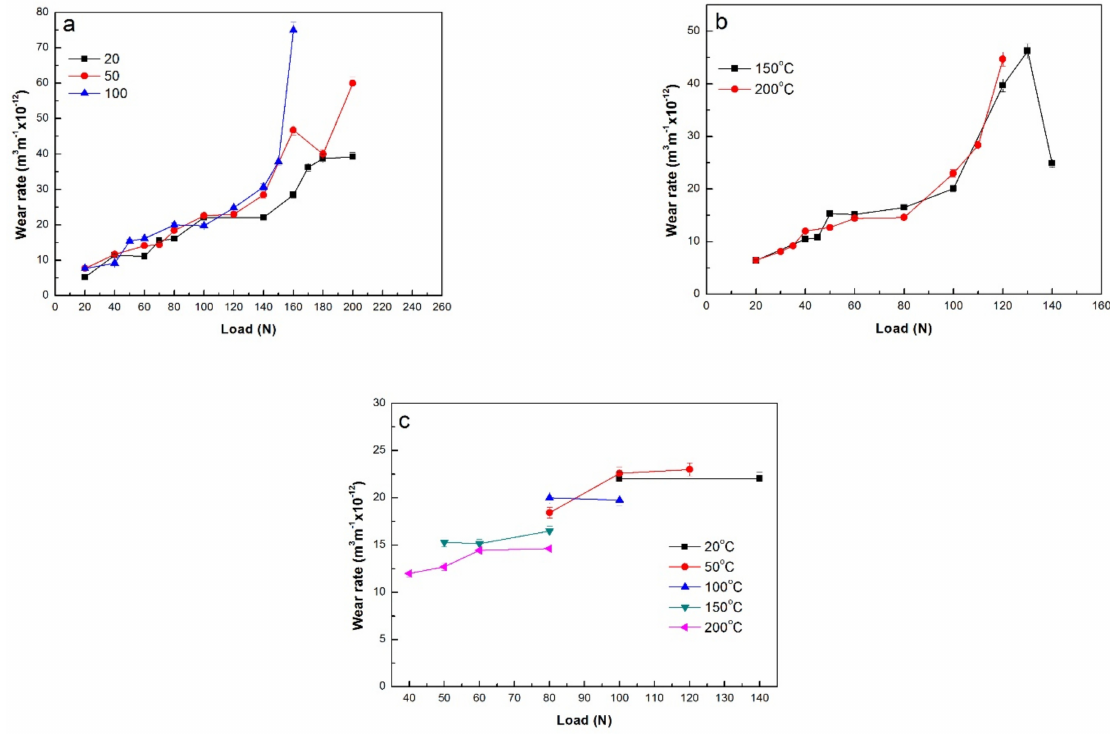
Figure 2. Wear rate versus applied load: ( a ) 20–100 ◦ C, ( b ) 150 and 200 ◦ C, ( c ) the second stages. Table 2. Load ranges corresponding to different stages at different test